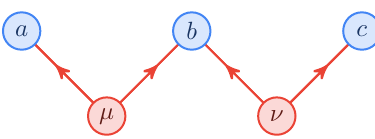
Figure 5: A causal structure G 5 with three visible vertices V = { a , b , c } and two latent vertices L = { µ , ν }